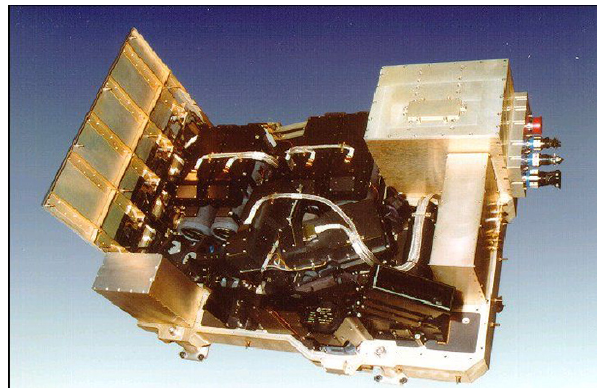
Figure 1. The GOME-2